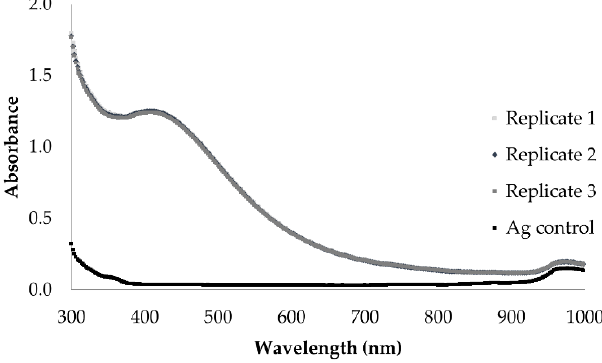
Figure 2. Biological AgNPs physicochemical characterisation. UV/Vis spectrophotometry analysis of the biologically synthesised AgNPs by the fungus C. thermophilum .